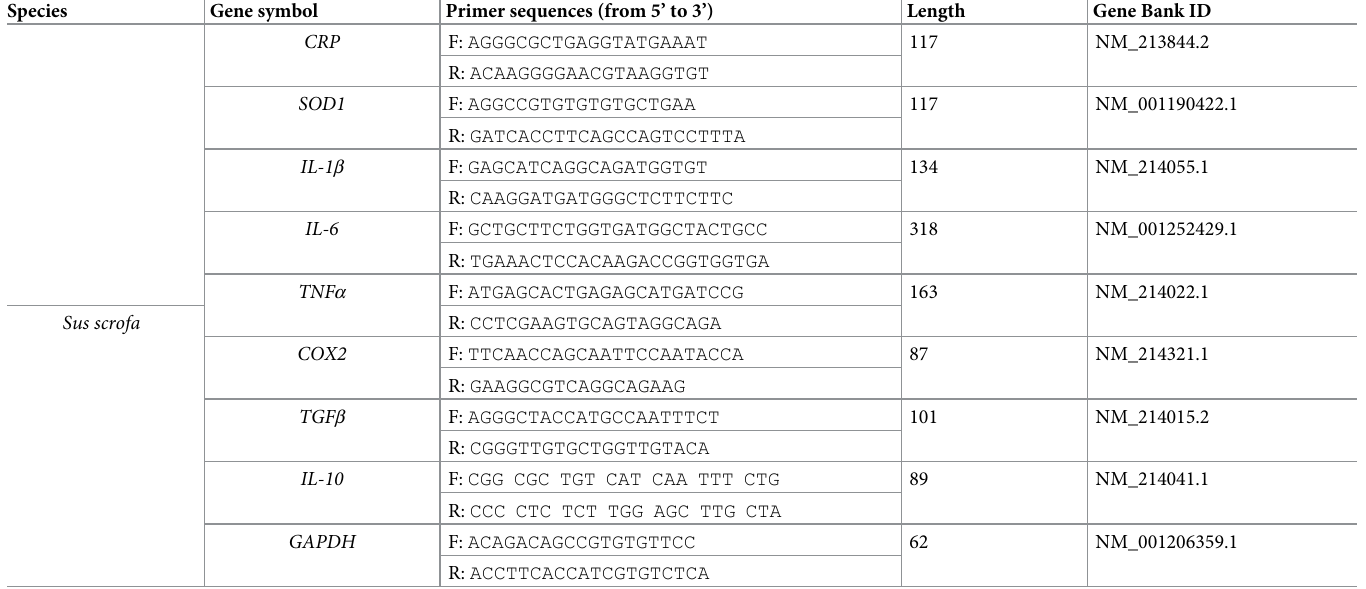
Table 1. Primers used for qRT-PCR. Species Gene symbol Primer sequences (from 5’ to 3’)